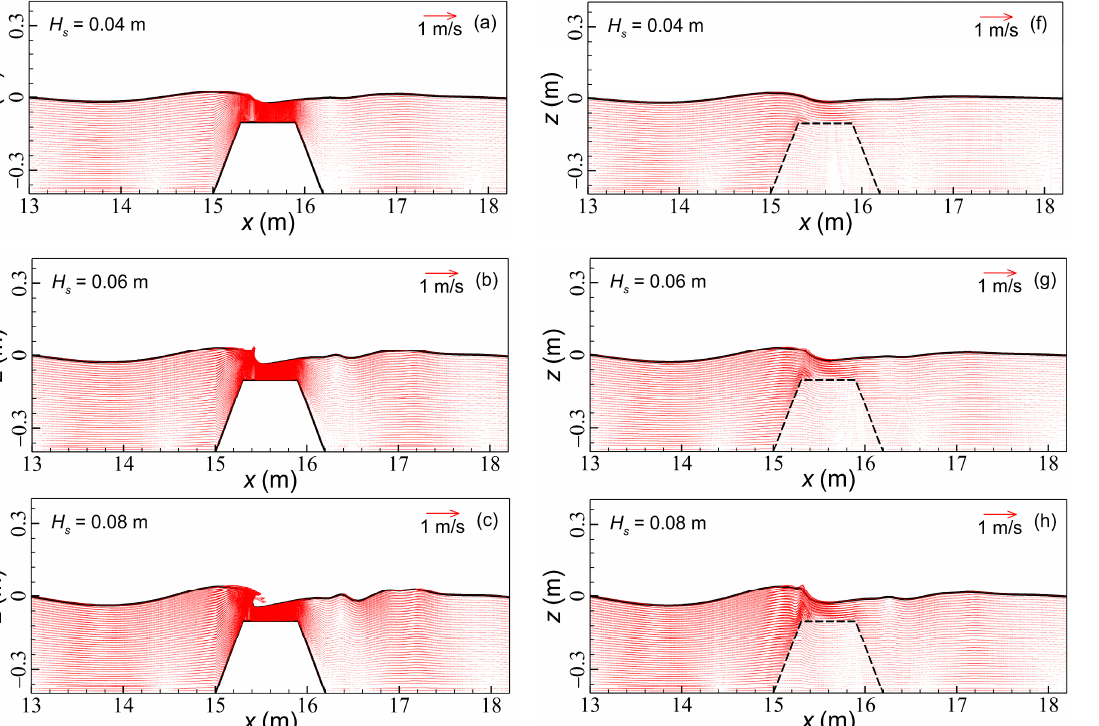
Figure 13. Comparisons of the snapshots of the vector velocity field around the submerged breakwater with different significant wave heights; left side ( a – e ): submerged impermeable breakwater; right side ( f – j ): submerged permeable breakwater.